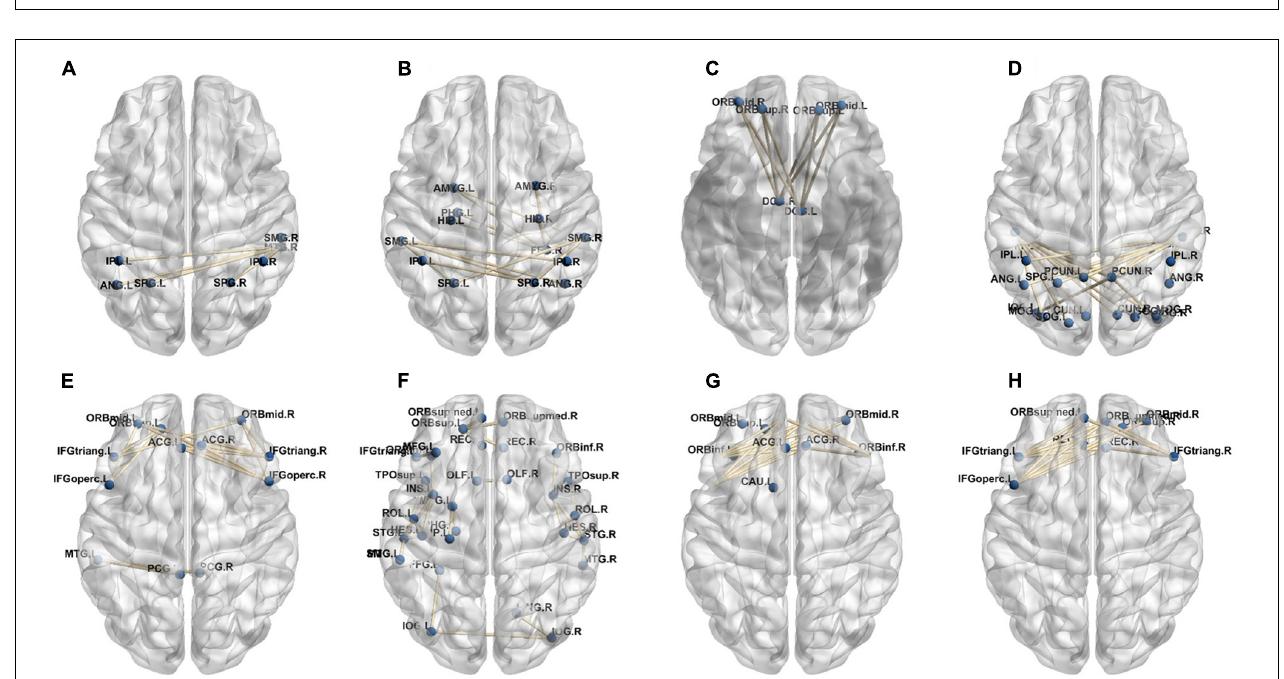
FIGURE 9 | Clusters of low-order FC network (1–8). (A–H) First to eighth clusters.